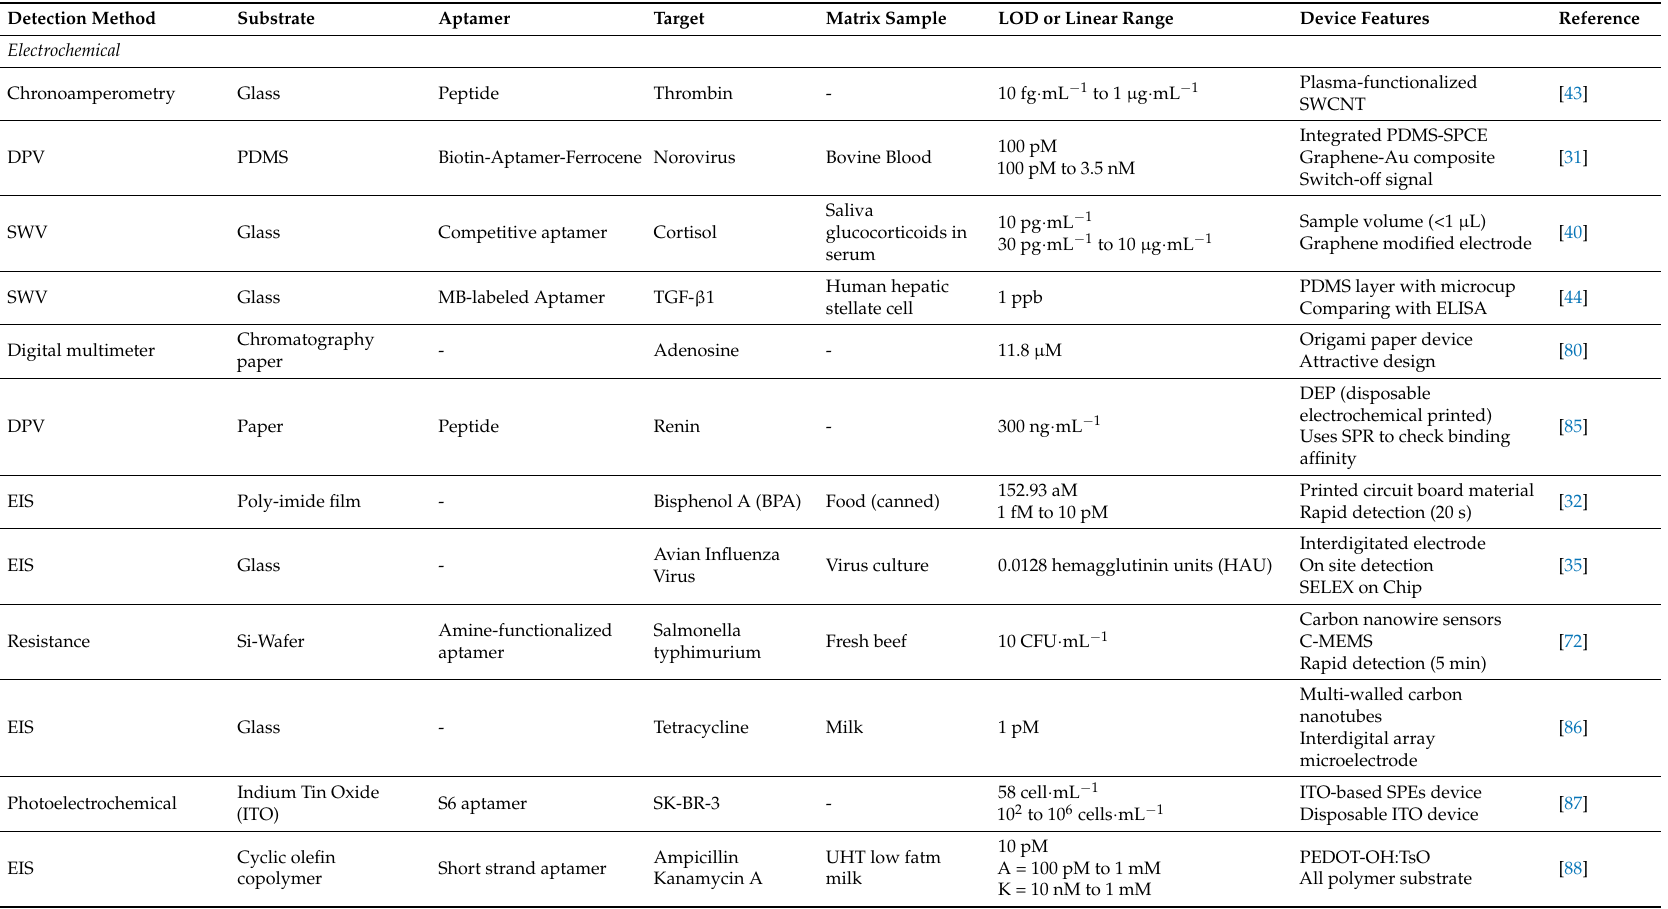
Table A1. Summary of microdevice-based aptasensors on several platforms and target